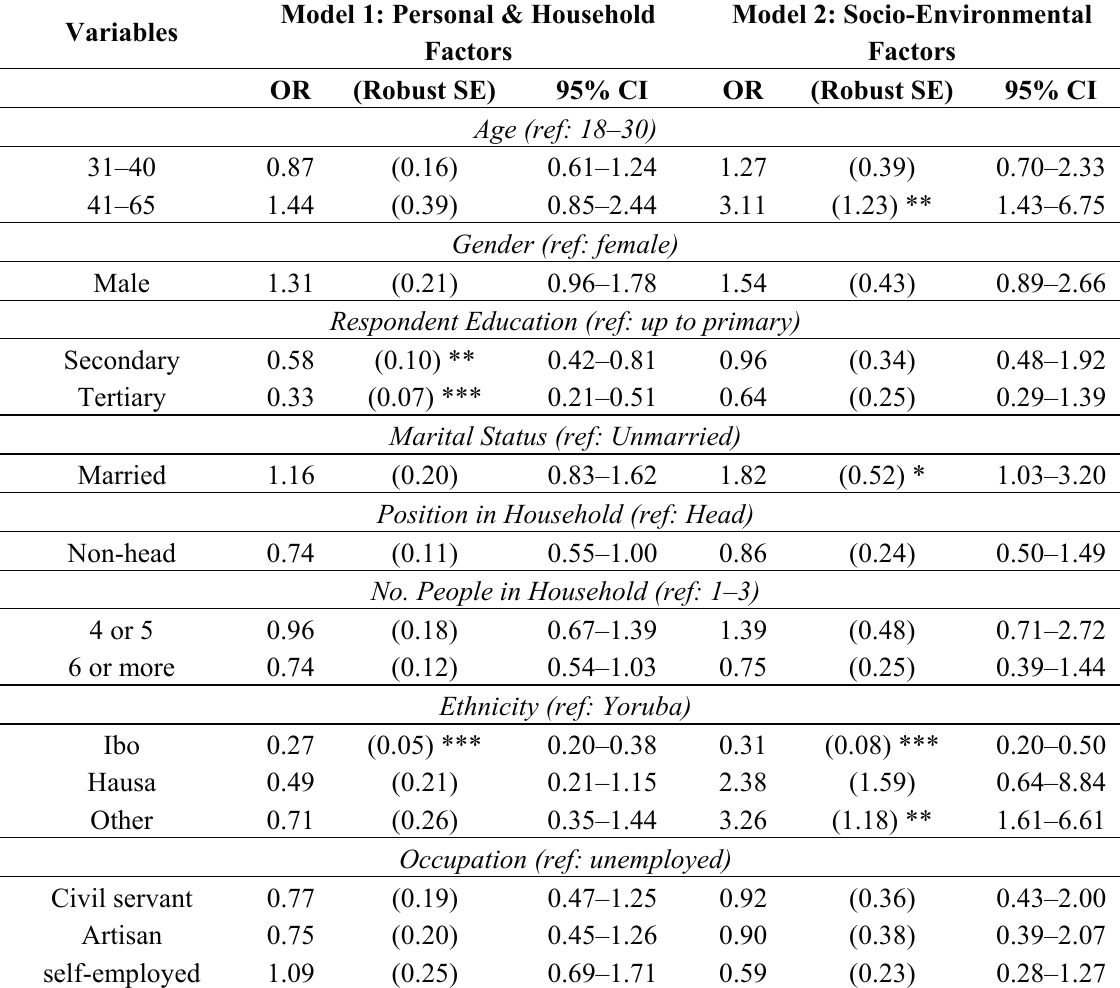
Table 4. Multivariate complementary log-log regression model predicting the experience of flooding by coastal communities in